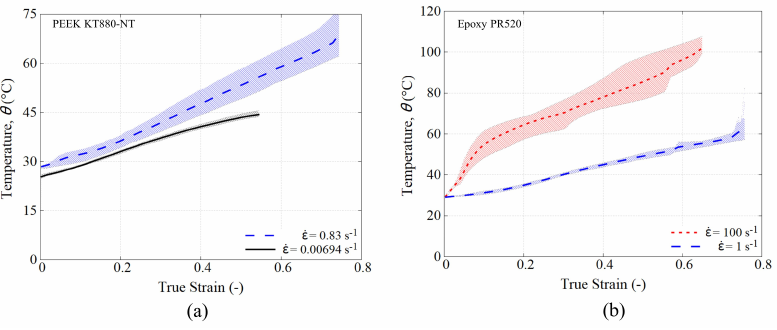
Figure 8. Temperature evolution at different strain rates: ( a ) PEEK KT880 − NT and ( b ) PR520.